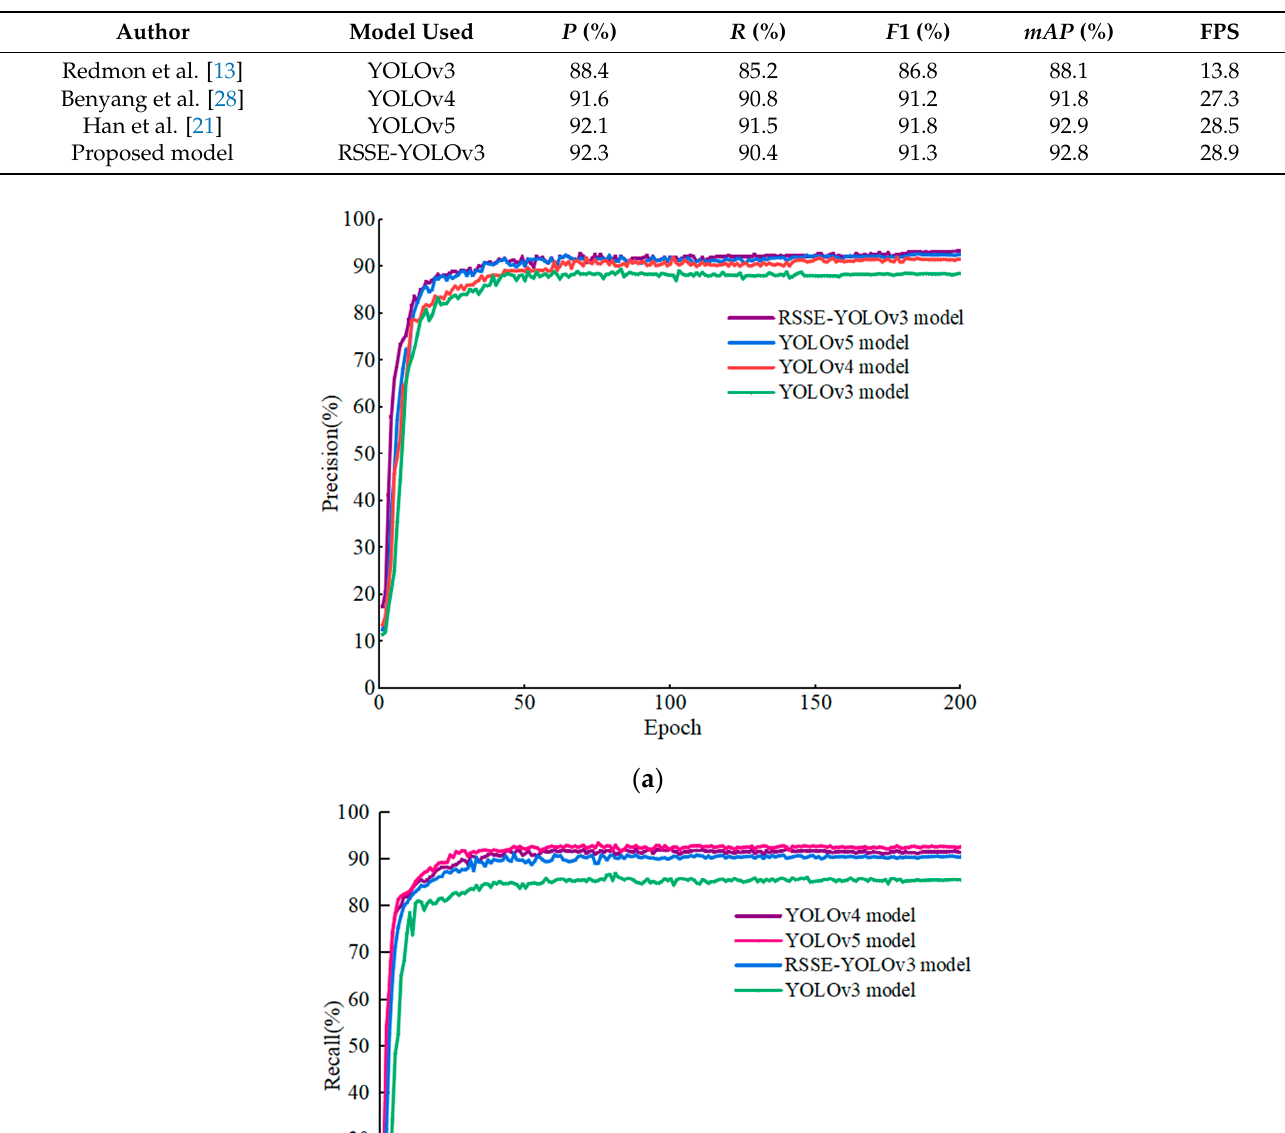
Table 5. Comparison of different algorithms for object detection.